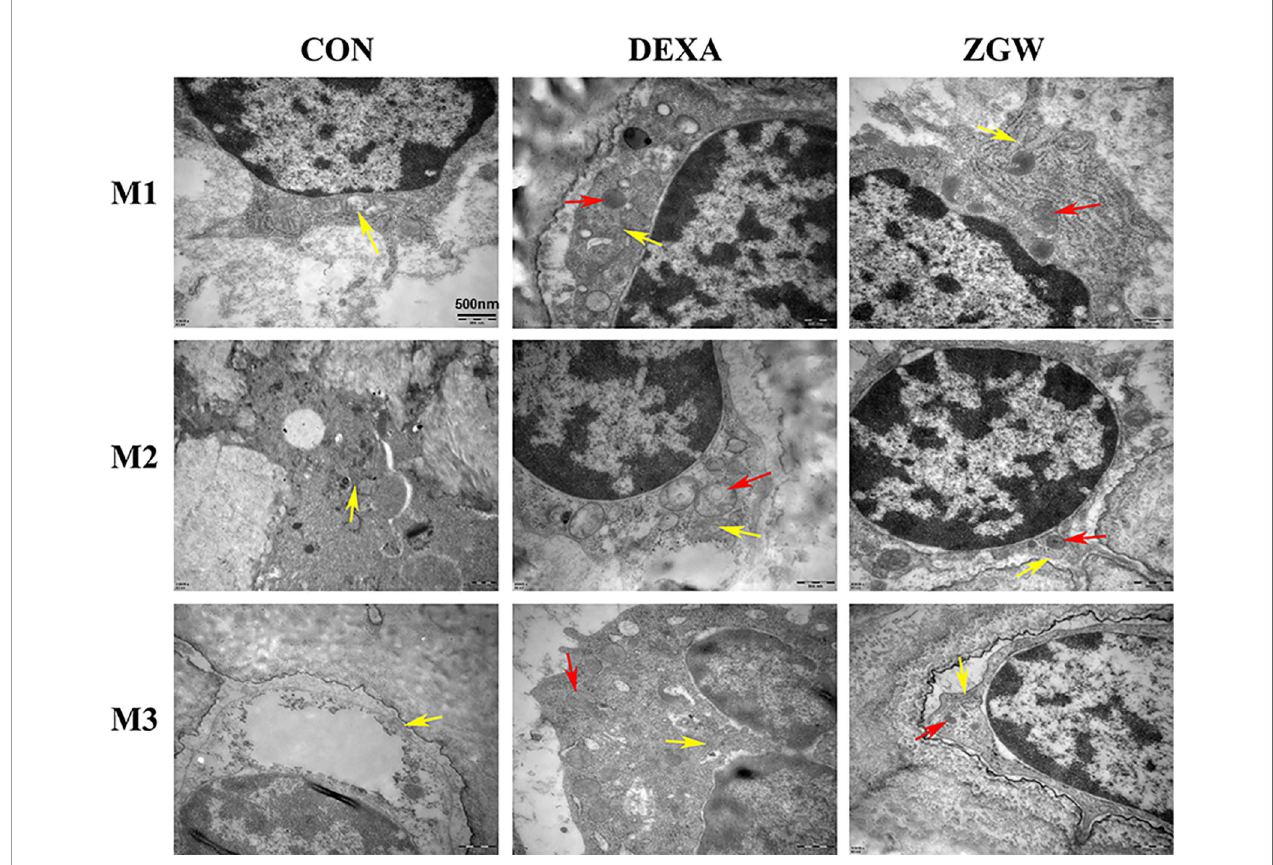
FIGURE 5 | Transmission electron microscopic observation. The yellow arrows indicate mitochondria, and the red arrows indicate